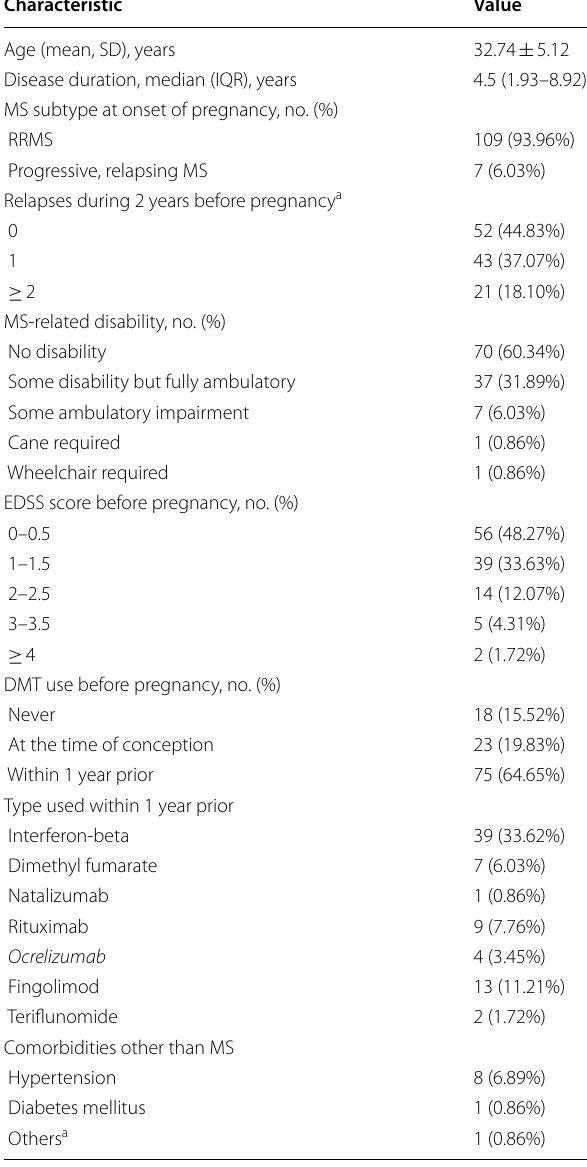
Table 1 Demographic characteristics of the included